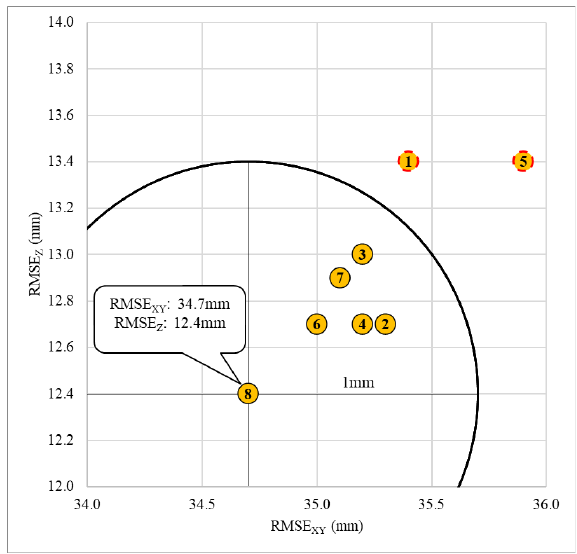
Figure 9 . Results from first round of